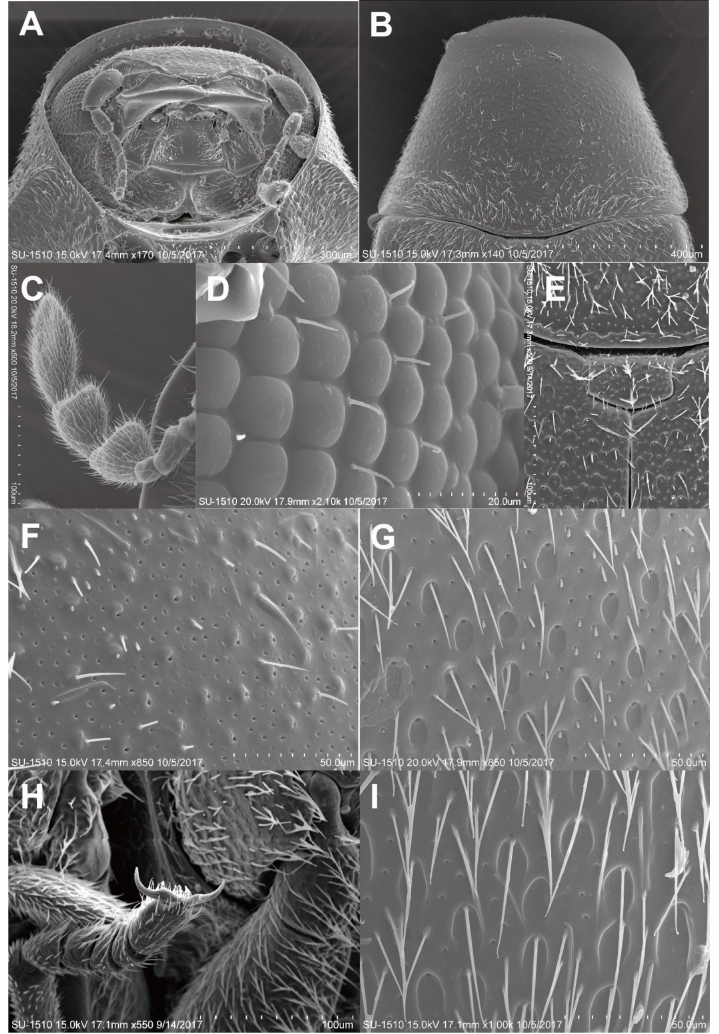
Figure3. Adultof Falsogastrallussauteri . ( A )Head, frontalview. ( B )Pronotum, dorsalview. ( C )Antenna, dorsal view. ( D ) Compound eye. ( E ) Scutellum, dorsal view. ( F ) Surface of Pronotum, dorsal view. ( G ) Surface of elytron, dorsal view. ( H ) Tarsi and claw. ( I ) Sternite, ventral